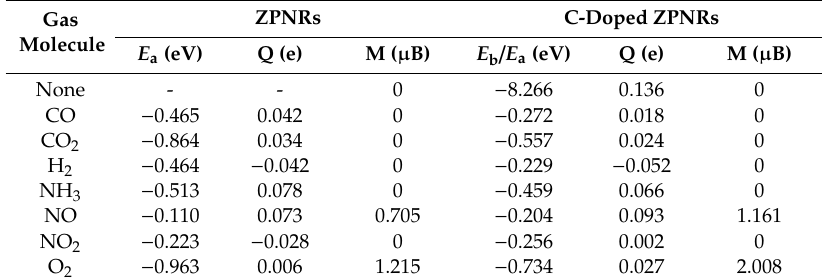
Table 1. adsorption energy ( E a )-VASP, Charge transfer (Q), and Magnetic moment (M) of gas molecules on ZPNRs and C-doped ZPNRs. on ZPNRs and C-doped